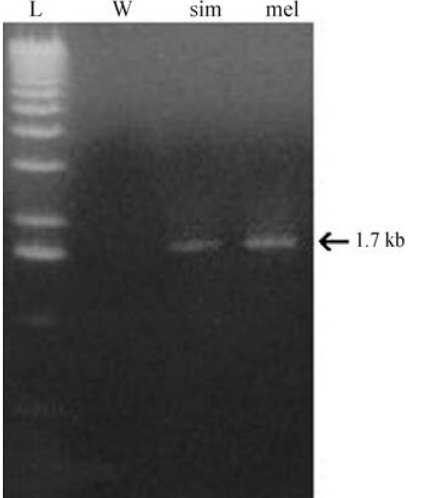
Figure 1 - The Bari-1 transposable element PCR products corresponding tothecompletesequencein D.simulans and D.melanogaster strainsvisu- alized in 1% agarose gel. Lanes are as follows: L, 1 kb DNA ladder size marker (GIBCO-BRL); W, water; sim, D. simulans C167.4; mel, D. melanogaster IN(1)AB.